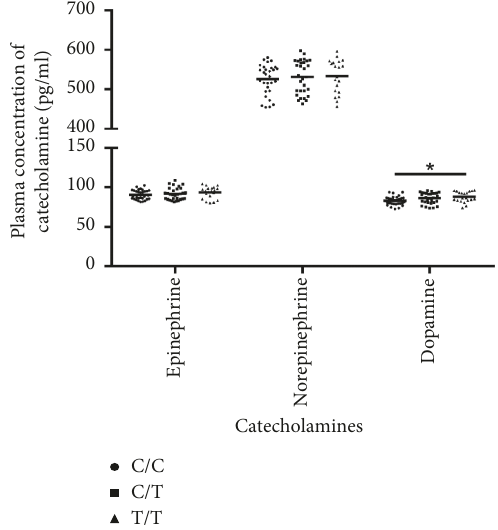
Figure 1: Comparison of plasma concentration of catecholamines in individuals with C/C ( n � 30), C/T ( n � 30), and T/T ( n � 20) genotypes of APOE rs7412